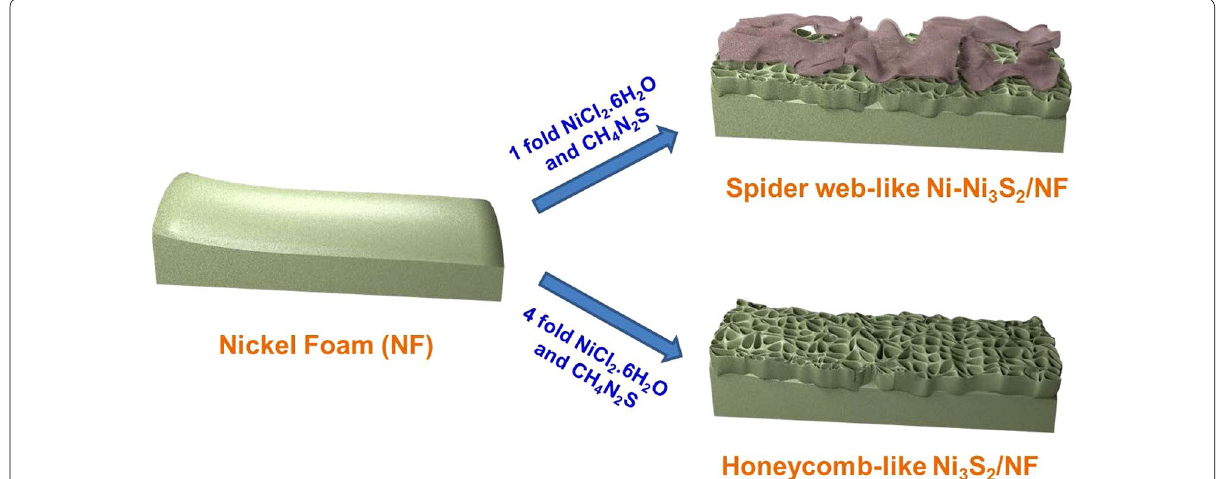
Fig. 1 Schematic representation of the preparation of SW Ni–Ni 3 S 2 /NF and HC–Ni 3 S 2 /NF